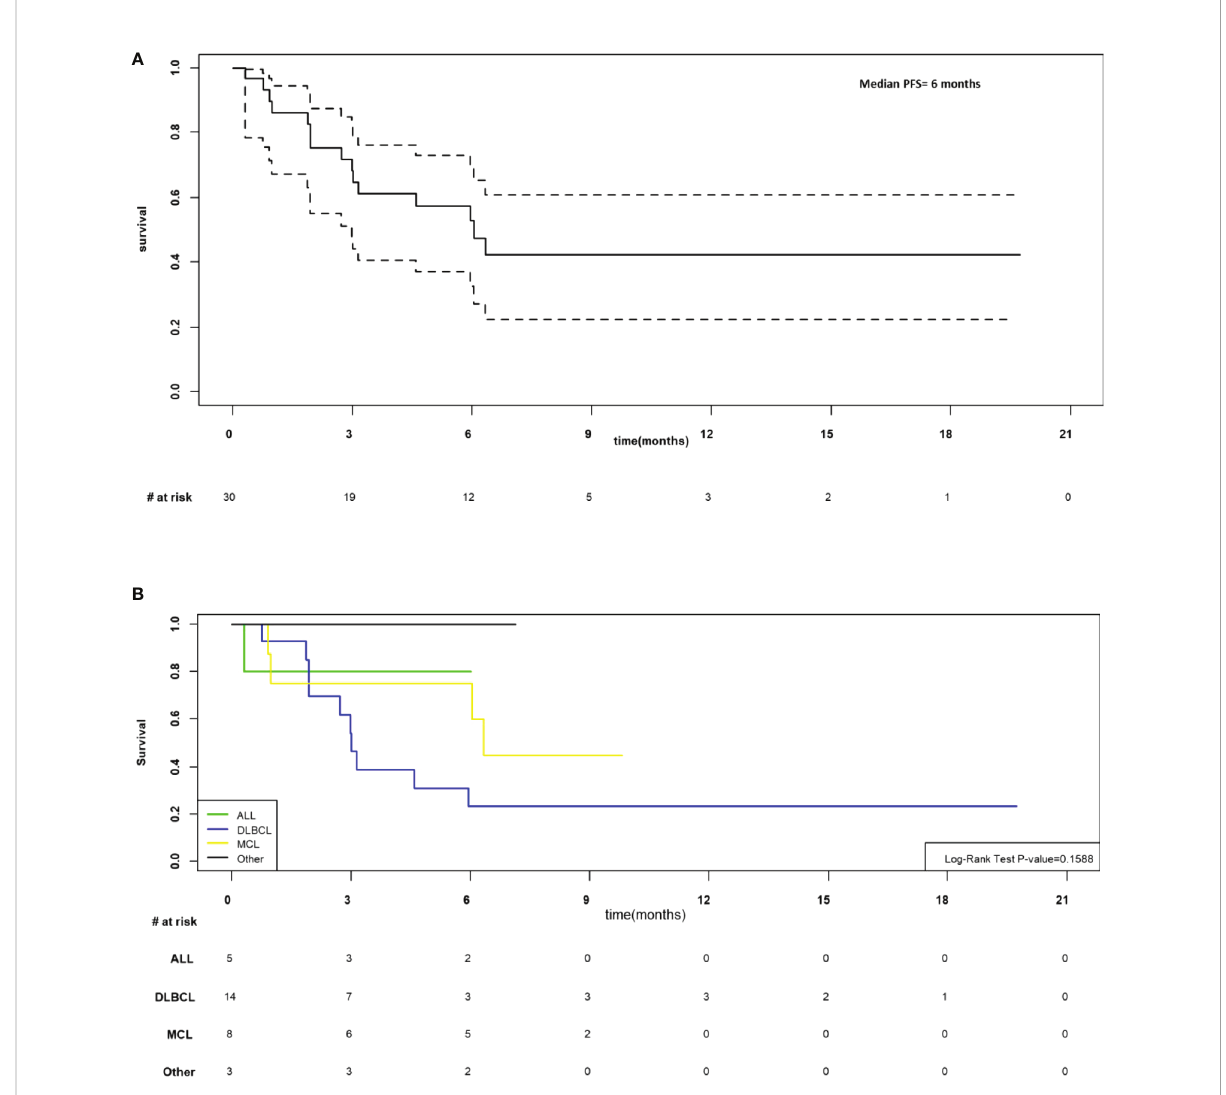
FIGURE 4 (A) Progression-free survival for N=30 infused. (B) Progression free survival by